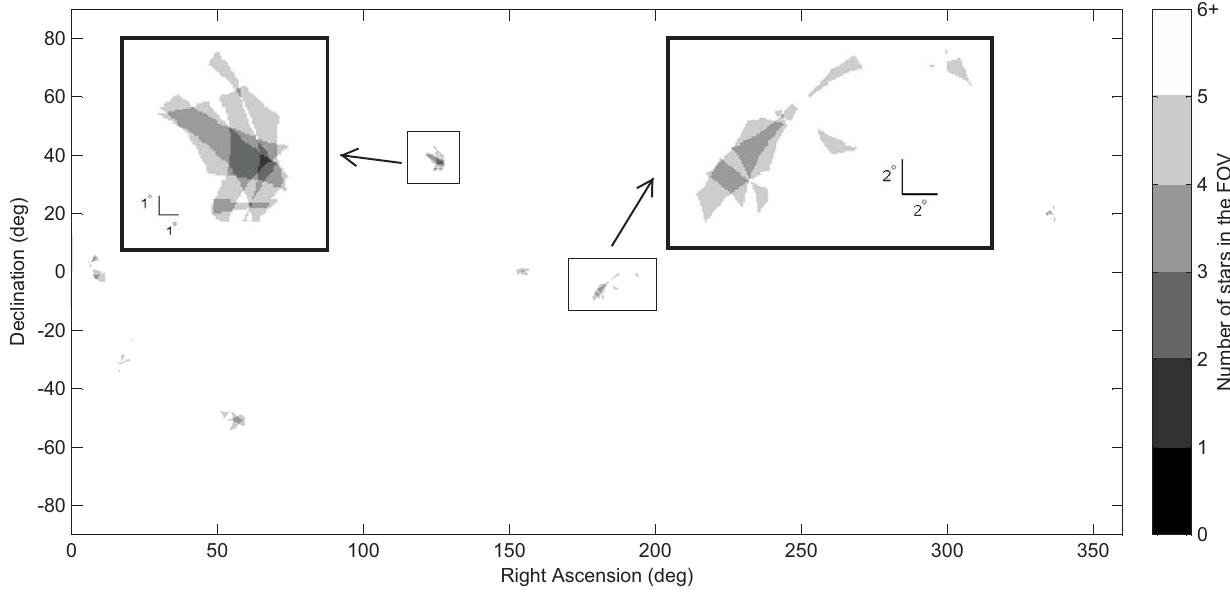
Figure 5. Sky regions with poor ST-16 star availability (0 deg/s). Note: the color axis is flipped with respect to Figure 4 to increase the visibility of star-sparse